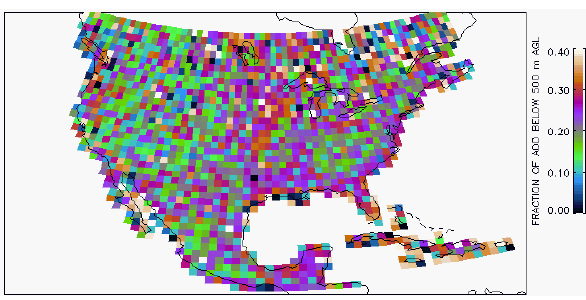
Figure 8. From 2006 to 2011, fraction of CALIOP-integrated 0.532µm extinction below 500m a.g.l. for the contiguous United States.